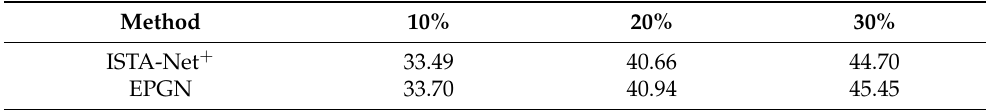
Table 3. PSNR (dB) of reconstructions obtained by ISTA-Net + and EPGN on MR images using radial masks with sampling ratios of 10%, 20%, and